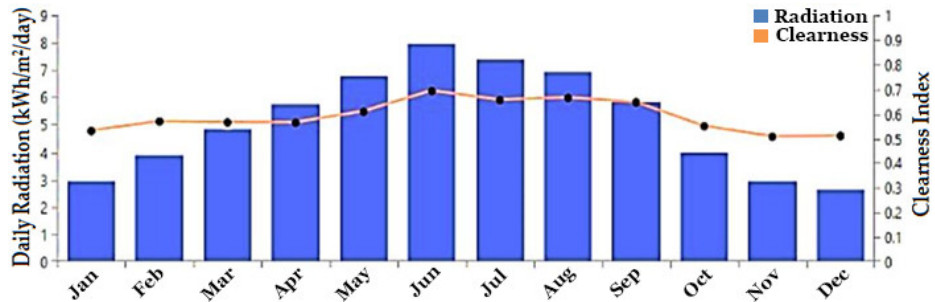
Figure 5. Monthly average solar global horizontal irradiance (GHI) data during 2020 .